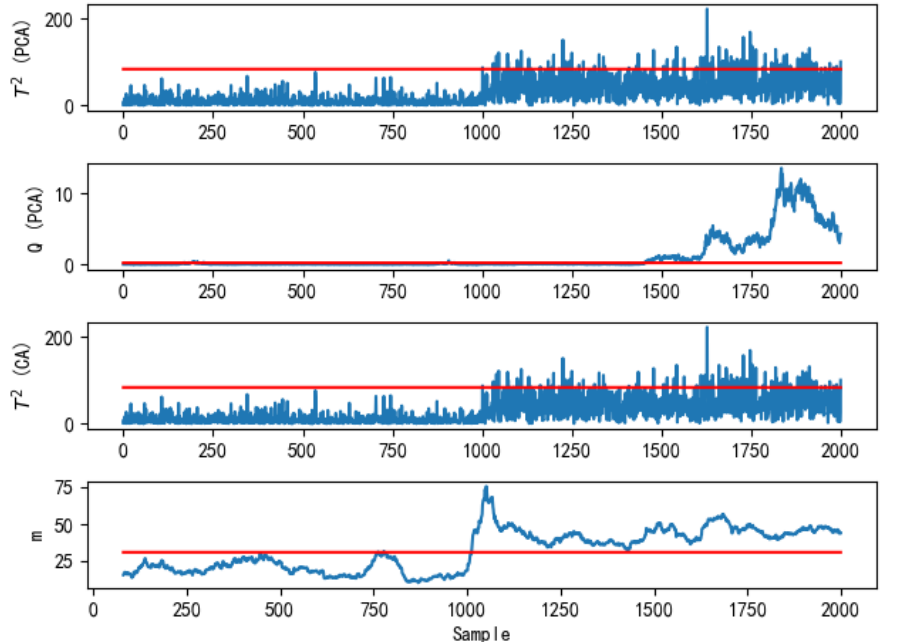
Figure 2. Monitoring results of the simulation data. Table 1. Monitoring results of the validation set with different window widths. Window Width